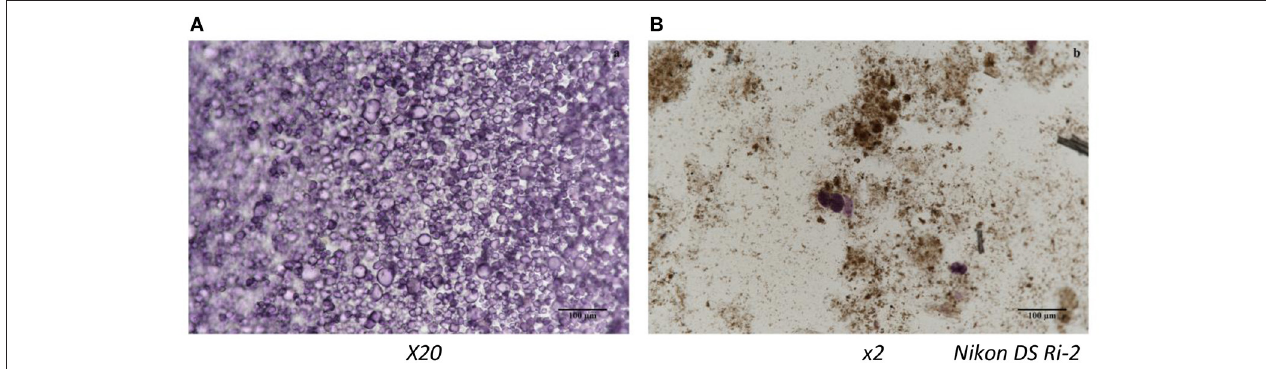
FIGURE 3 | Light Microscopy image showing the microstrucutre of starch granules in OFSP puree (Lugol’s test): (A) without blanching sterilized and (B) blanching sterilized.